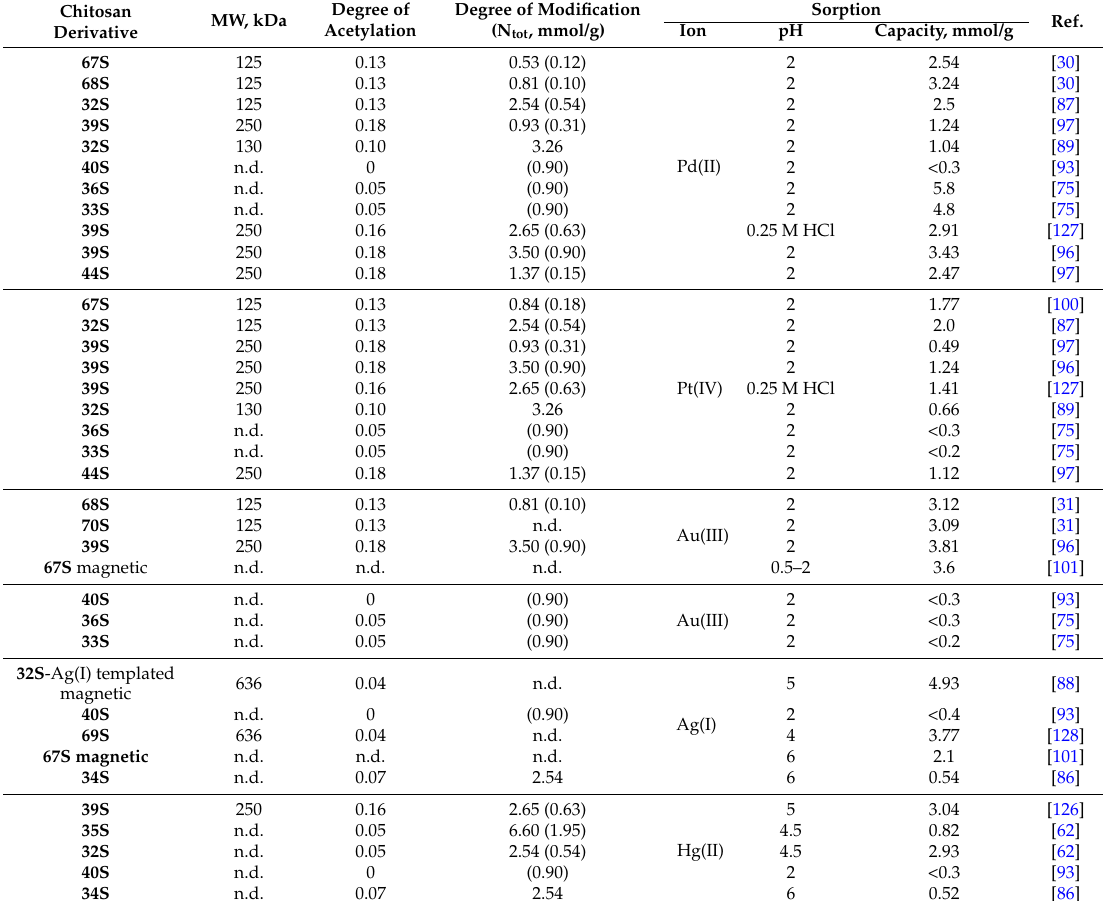
Table 4. Structure and sorption properties of S-containing chitosan derivatives Degree of Degree of Modification Chitosan MW, kDa Acetylation (N tot , mmol/g) Derivative